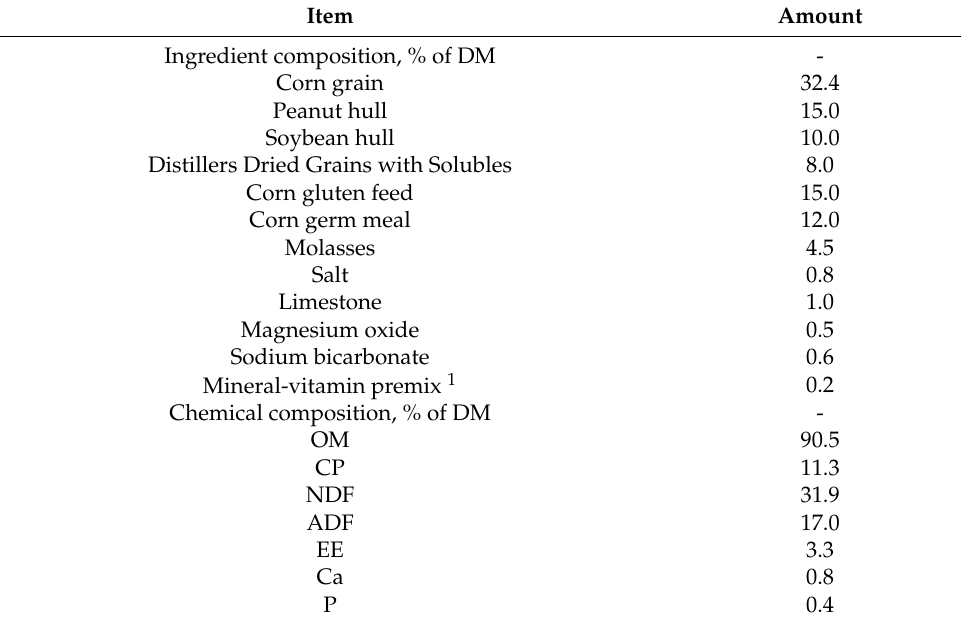
Table 1. Ingredients and nutrient compositions of the dietary treatments. Item Amount Ingredient composition, % of